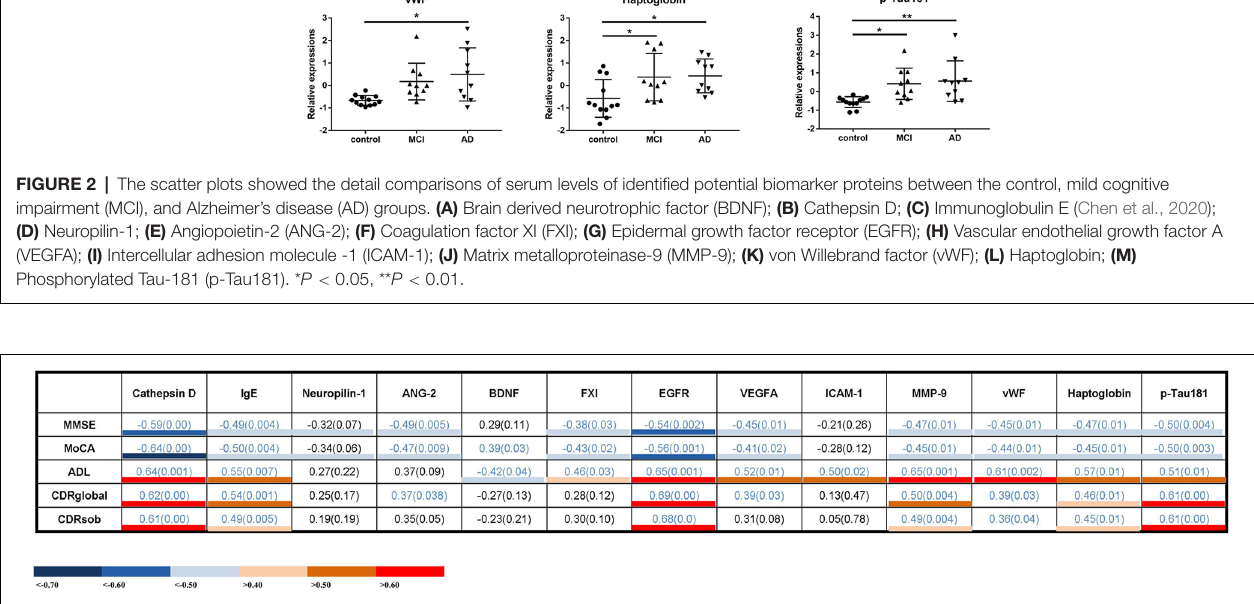
FIGURE 3 | Correlations between serum levels of potential biomarker proteins and cognitive measures. The values presented are Spearman’s rank coefficients r 2 . Blue values indicate a P < 0.05. The color key indicates the strength of correlations based on the correlation coefficients. IgE, immunoglobulin E; ANG-2, angiopoietin-2; BDNF, brain-derived neurotrophic factor; EGFR, epidermal growth factor receptor; VEGF, vascular endothelial growth factor; ICAM-1, intercellular adhesion molecule -1; MMP-9, matrix metalloproteinase-9; vWF, von Willebrand factor; p-Tau, Phosphorylated Tau; MMSE, Mini-Mental State Examination; MoCA, Montreal cognitive assessment; ADL, activities of daily living; CDRglobal, Clinical Dementia Rating global; CDRsob, Clinical Dementia Rating sum of